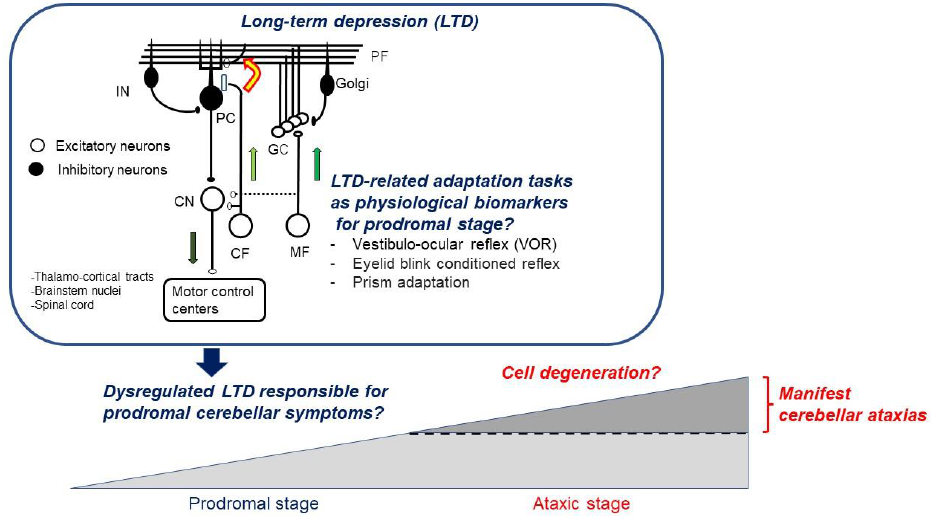
Figure 1. Dysregulated LTD responsible for prodromal cerebellar symptoms. MF: mossy